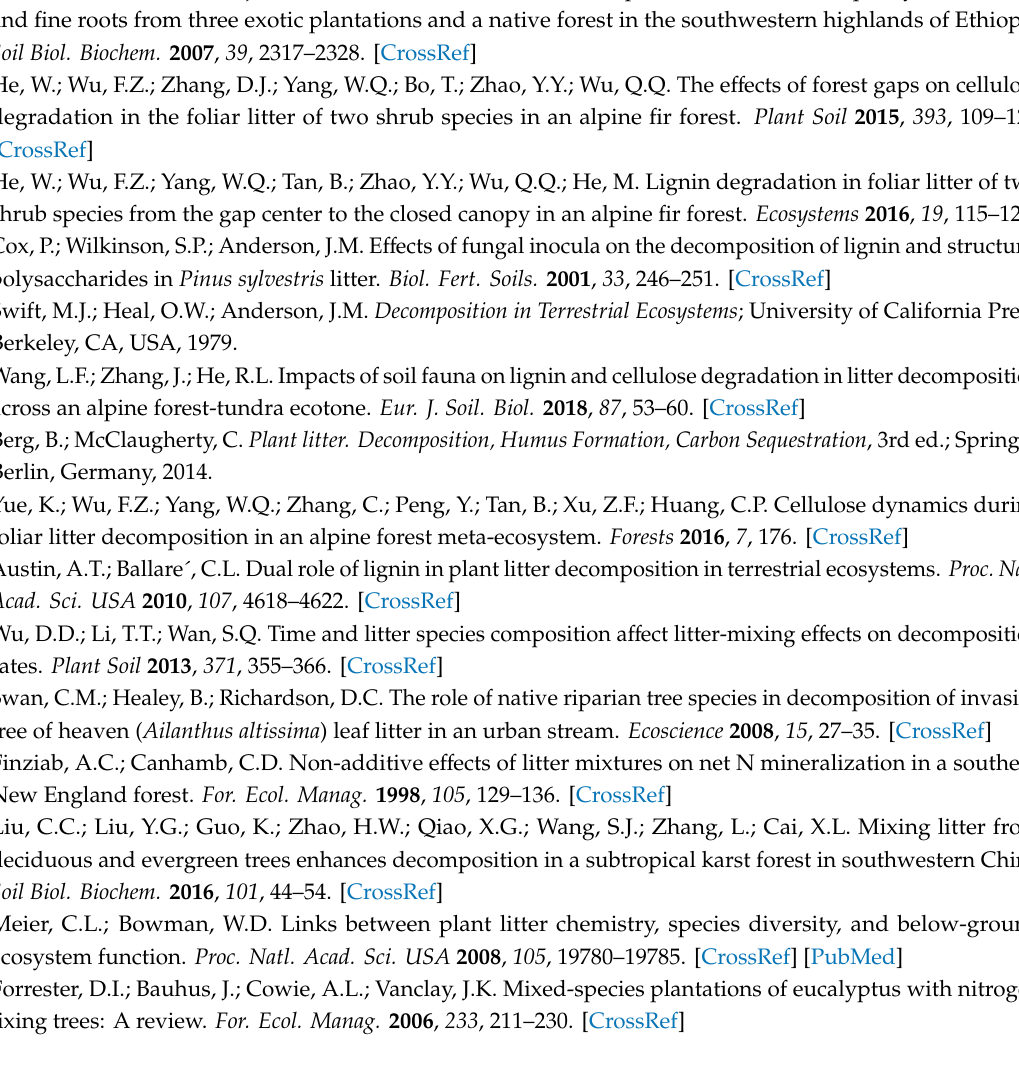
Table S1: Initial litter chemistry (mean ± SE, n = 3) in litter treatments, Table S2: Average Temperature ( ◦ C) and Cumulative Precipitation (mm) in each phase of